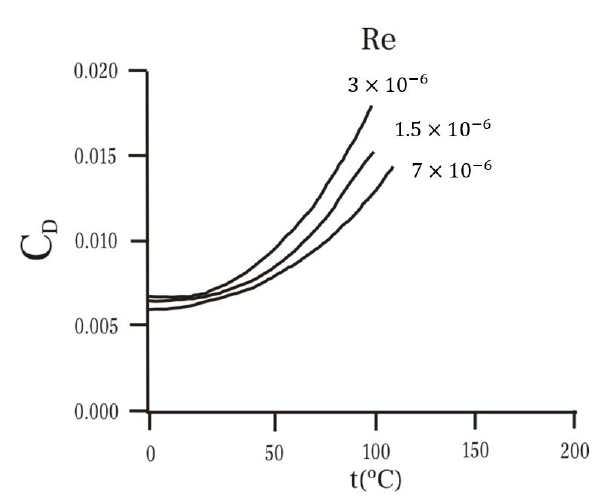
Figure 1. Drag coefficient vs.